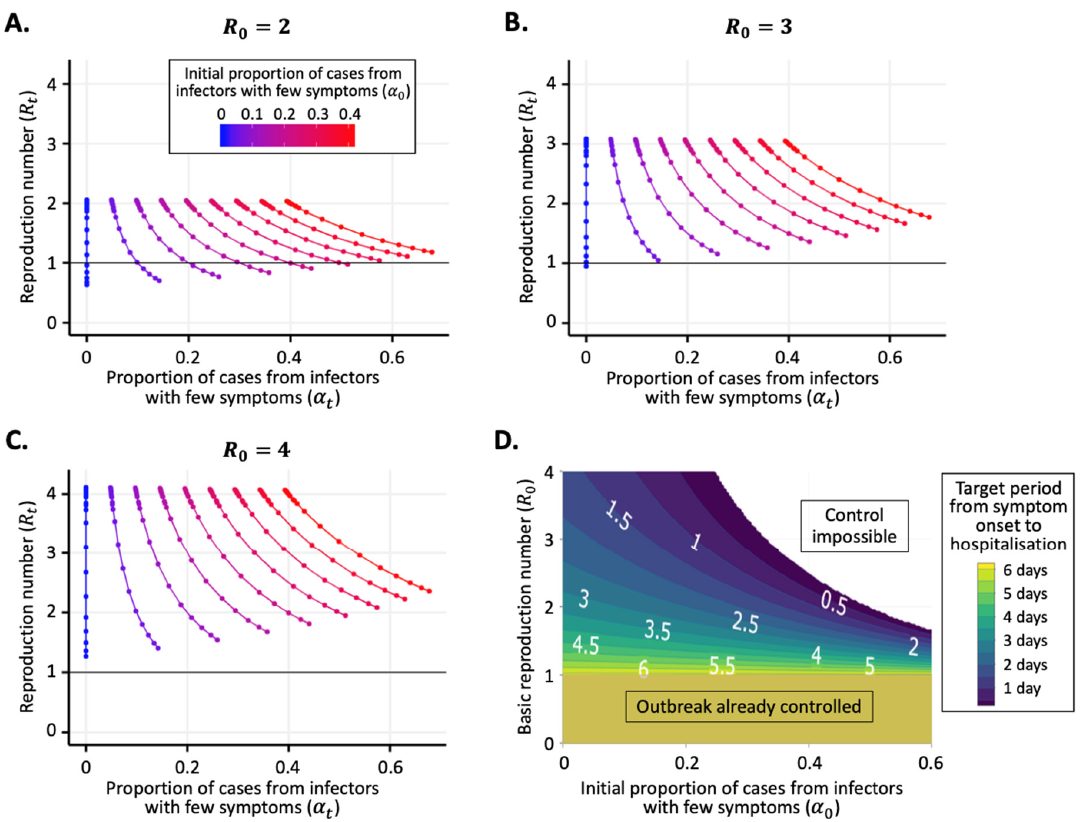
Figure 2. The reproduction number ( R t ) and the proportion of transmissions from hosts with few symptoms ( α t ) vary in response to changes in the period between symptom onset and hospitalisation. ( A ) Variation in R t and α t between 2 January and 22 January 2020 due to changes in the mean time from symptom onset to hospitalisation (1/ γ t days; see Figure 1B), under the assumption that R 0 = 2. Values of R t and α t were calculated using Equations (1) and (2), respectively. Lines represent di ff erent values of the initial proportion of transmissions from hosts with few symptoms ( α 0 ). Values of α 0 between 0 and 0.4 were considered in steps of 0.05 (i.e., nine values in total). In the period from 2 January to 22 January 2020, transmissions from hosts with clear symptoms were typically prevented increasingly e ff ectively, leading to a temporal trend from the tops to the bottoms of the lines shown. ( B ) Equivalent figure to panel A, but with R 0 = 3. ( C ) Equivalent figure to panel A, but with R 0 = 4. ( D ) Required time within which symptomatic infectious hosts must be isolated on average (1/ γ t days) so that R t is less than one (i.e., the outbreak is controlled), calculated using Equation (1) for di ff erent pairs of values of α 0 and R 0 . In panels A-C, the horizontal black line shows the threshold value of R t for outbreak control ( R t = 1). The value of 1/ γ 0 used in all panels is 6.7 days (as estimated in Figure